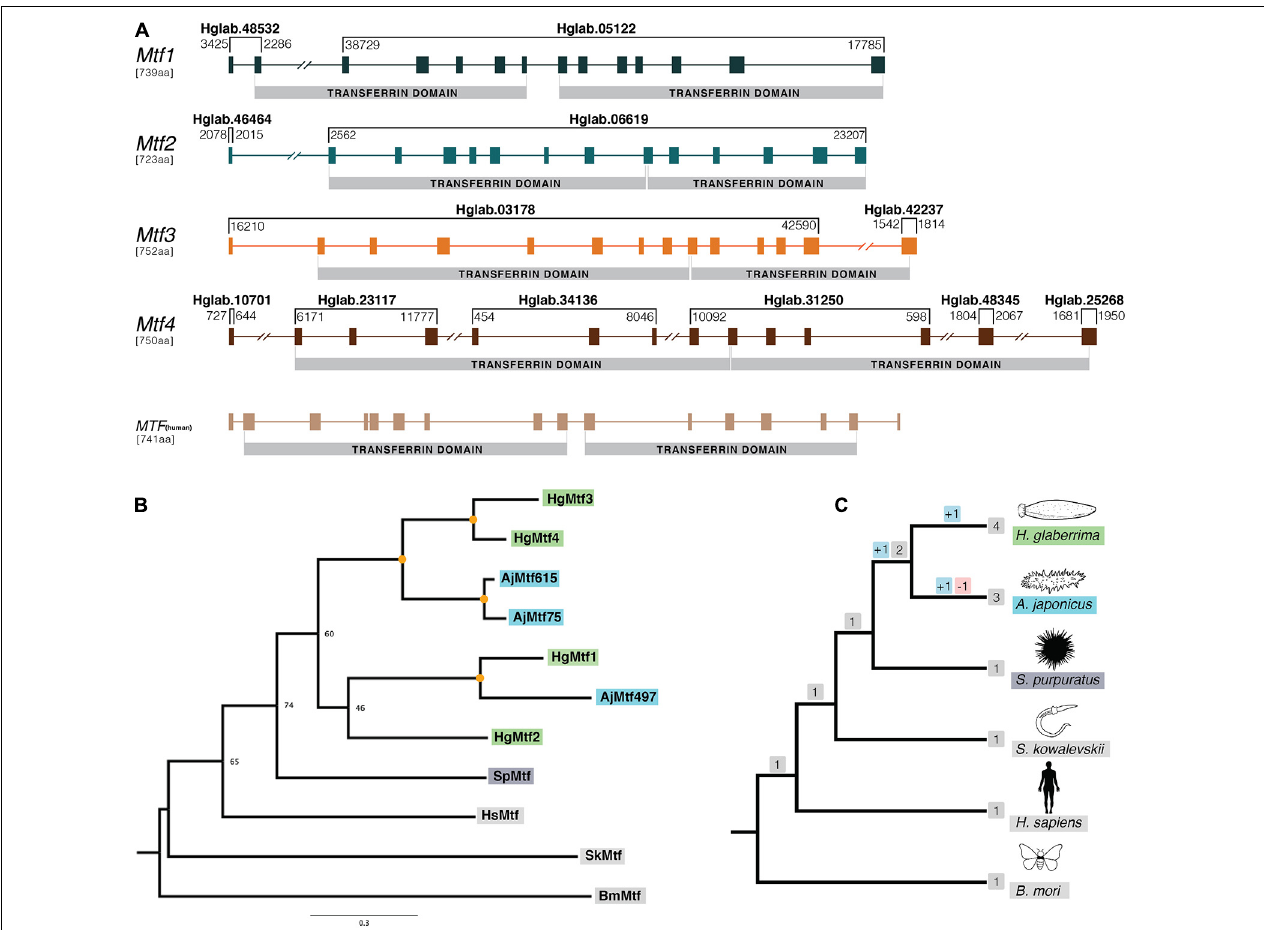
FIGURE 2 | Gene structure and phylogenetic analysis of H. glaberrima melanotransferrin (Mtf) genes. (A) Genomic structure was determined using H. glaberrima Mtf gene and protein sequences present in NCBI from previous studies from Hernández-Pasos et al. (2017). Scaffolds containing specific exons of the genes are shown at the top of each bracket (e.g., Hglab.48532). Coordinates of the sequence in each scaffold are shown among brackets based on genome nucleotide sequence. Human Mtf gene structure was acquired from NCBI genome browser ( MELTF NCBI: NM_005929.6). Transferrin domains are shown at the bottom of each gene. (B) Gene tree of all Mtf genes from H. glaberrima (Hg) , A. japonicus (Aj) , S. purpuratus (Sp), H. sapiens (Hs), S. kowalevskii (Sk), and B. mori (Bm). Mtf gene sequences of the last three species were acquired from NCBI. A. japonicus Mtf gene names represent the scaffold number where they are found in its genome assembly. Orange circles in nodes indicate bootstrap values of 100. (C) Species tree of organisms used in the phylogenetic analysis of the Mtf genes. Gene duplication and loss are shown in red and blue squares,